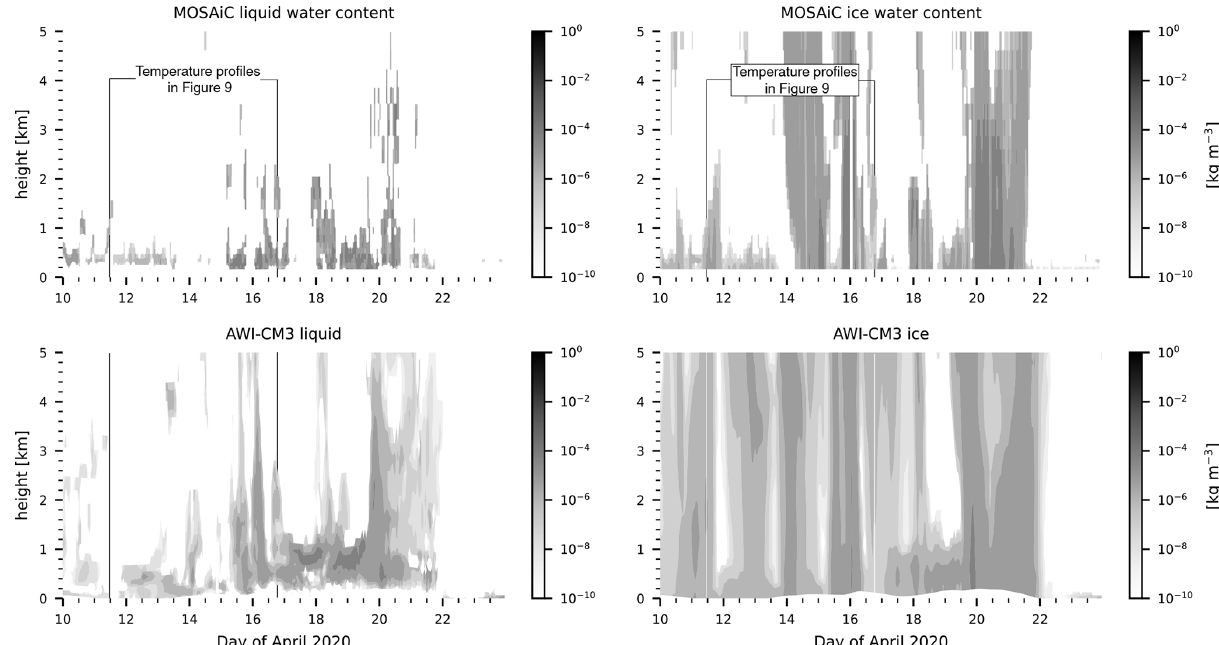
Figure 6. Observed and modelled (AWI-CM3) liquid and ice water content (sum of cloud and precipitation) for the period 9 to 23 April 2020. Vertically resolved prognostic precipitation was not output by the other